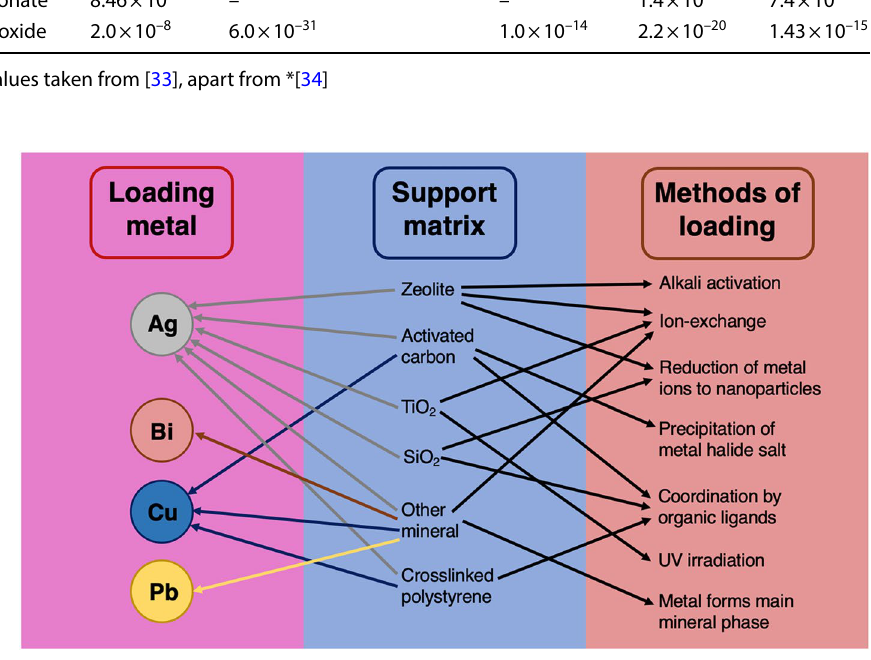
All values taken from [33], apart from